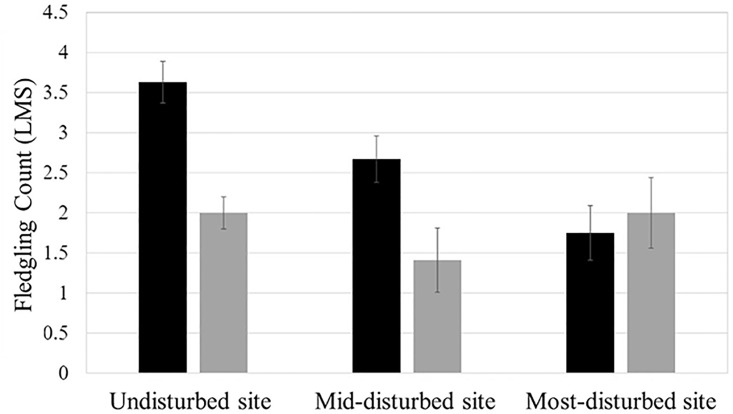
Least mean squares (LMS±SE) fledgling count estimates.For each site, TUTI data are represented by the left bar (black), while CACH data are represented by the right bar (grey).